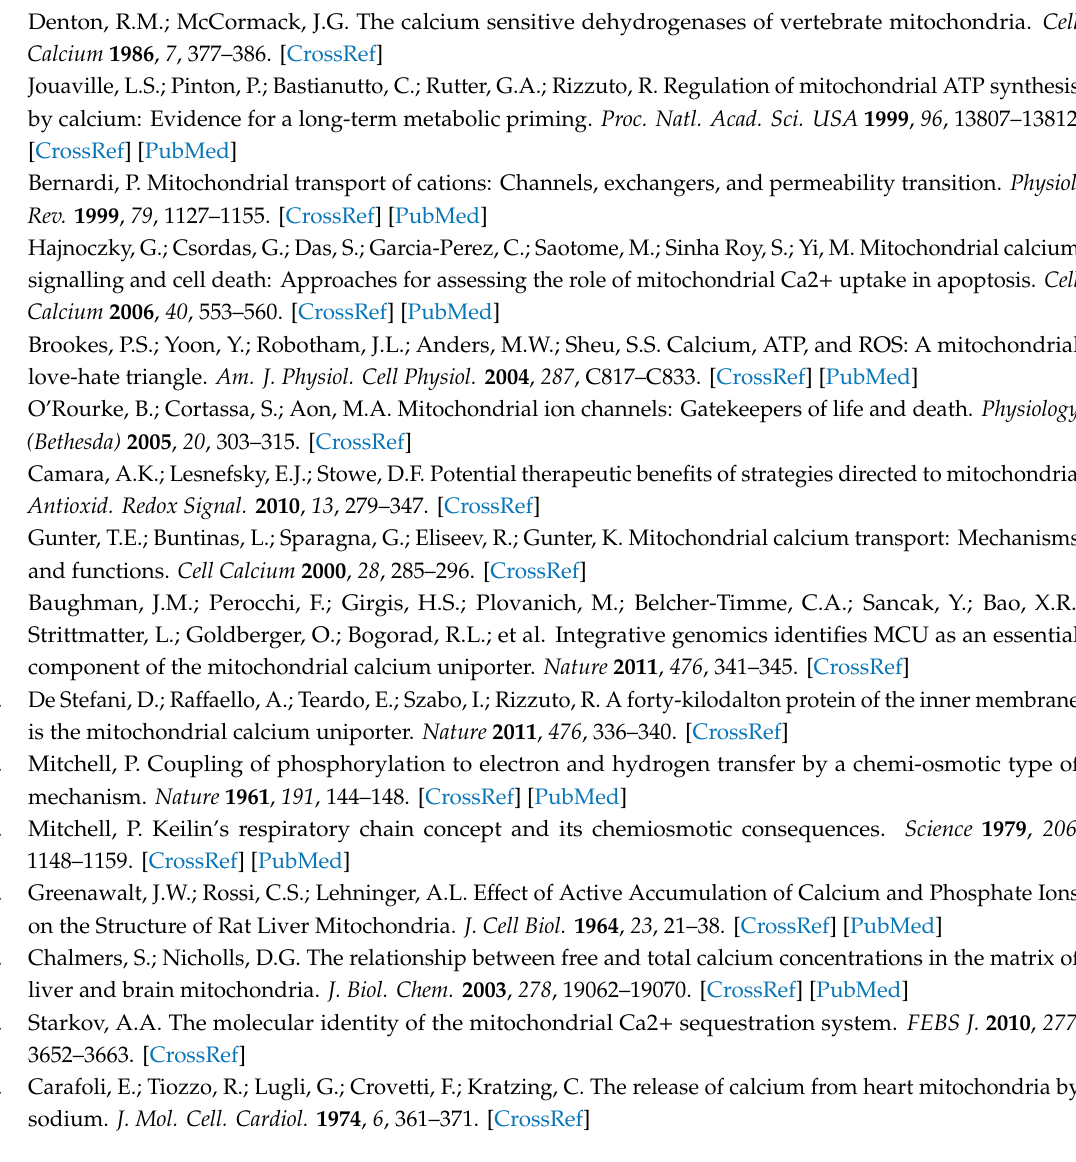
Figure S1: Quantification of calcium retention capacity (CRC) for each treatment, DMSO (control), ADP, oligomycin (OMN), OMN + ADP, and CsA during Protocol A (A) and Protocol B (B). Figure S2: Average Ca 2 + added before mPTP opening, ∆Ψ m collapse, NADH oxidation, and matrix acidification. Figure S3: Trend-fits for calculation of bu ff ering rate. Figure S4: Fura-4F ratio representing the change in [Ca 2 + ] e before and after adding a 20 µ M CaCl 2 bolus in the absence or presence of 250 µ M ADP in the mitochondria-free experimental bu ff er. Figure S5: Representative raw traces of extra-matrix Ca 2 + fluorescence (Fura-4F ratio) and Ca 2 + uptake in mitochondria pretreated with 0.5% DMSO (control), OMN + ADP, and CATR (carboxyatractyloside) + OMN + ADP prior to mPTP